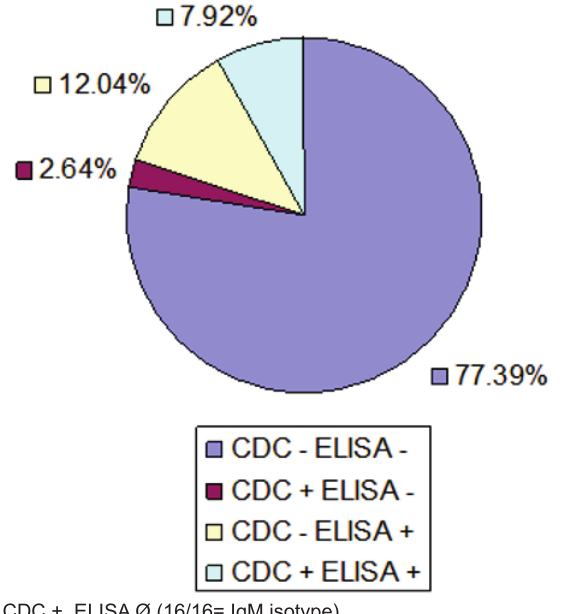
Figure 1. CDC and ELISA HLA Class I screening results.